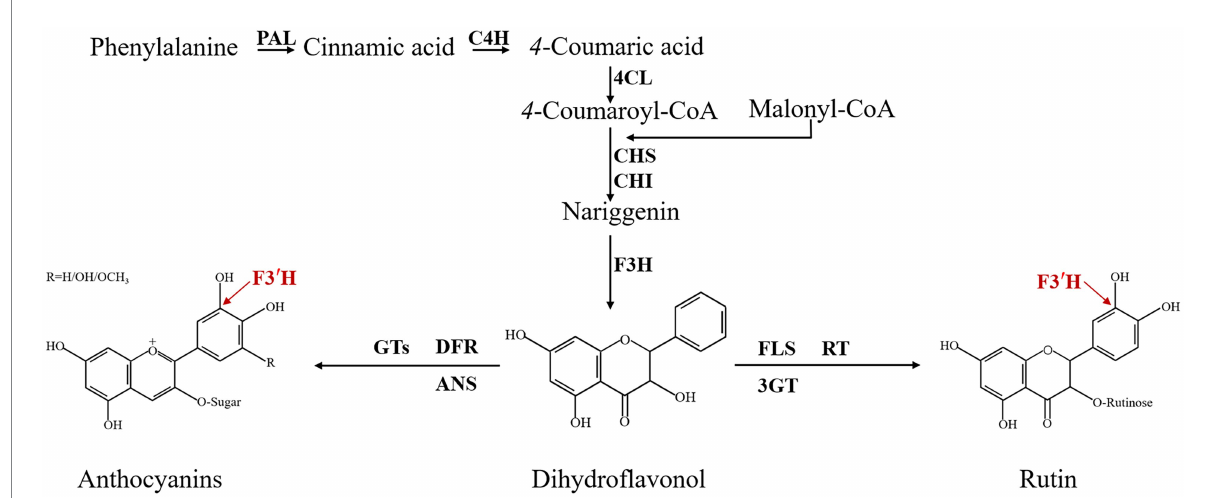
FIGURE 1 Flavonoid biosynthesis pathway of TB. PAL: phenylalanine ammonialyase; C4H: cinnamate 4-hydroxylase; 4CL: 4-coumarate CoA ligase; CHS: chalcone synthase; CHI: chalcone isomerase; F3H: flavanone 3-hydroxylase; F3 ′ H: flavonoid 3 ′ -hydroxylase; DFR: dihydroflavonol 4-reductase; FLS: flavonol synthase; ANS: anthocyanidin synthase; GTs: glucosyl transferases; 3GT: flavonoid 3-O-glucosyltransferase; RT: